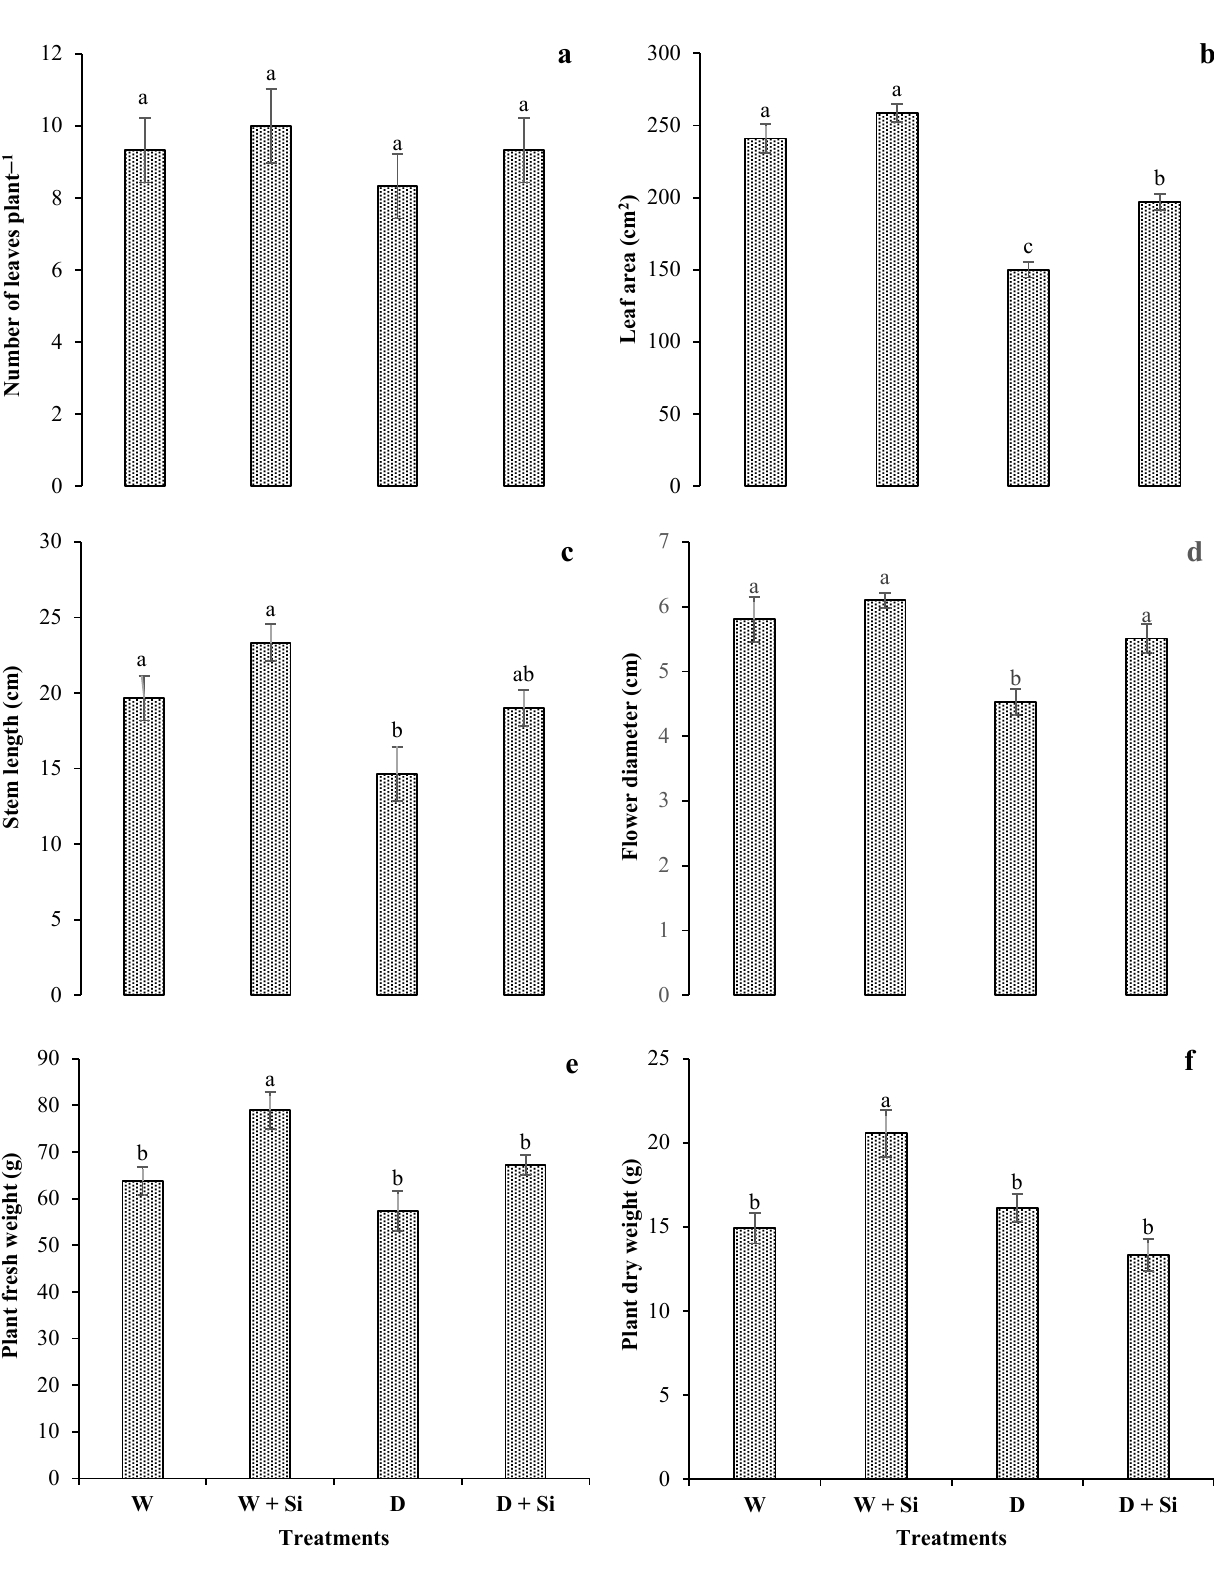
Figure 1. Influence of Si supplementation on the number of leaves ( a ), the leaf area ( b ), the stem length ( c ), the flower diameter ( d ), the plant fresh weight ( e ), and the plant dry weight ( f ) of Gerbera jamesonii under water-deficient conditions. Each bar shows a mean of four replicates ± SE. Dissimilar lettering illustrates significant statistical differences at p ≤ 0.05 after applying LSD